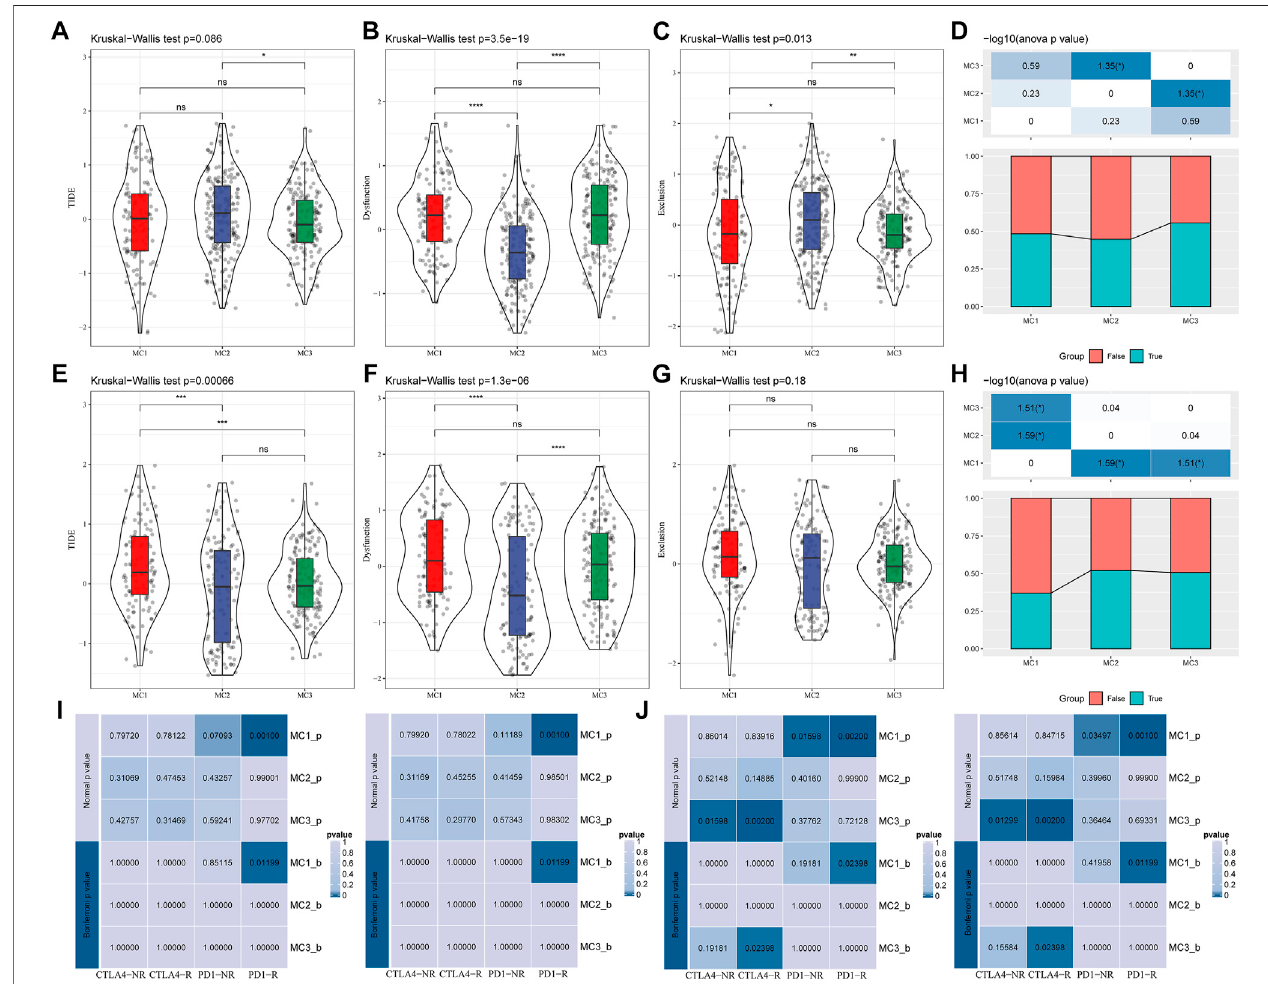
FIGURE 4 | The immunotherapy response difference between the three clusters. (A) TIDE scores of all three metabolic subtypes in the TCGA cohort. (B) T cell dysfunctionscoresofallthreemetabolicsubtypesintheTCGAcohort. (C) TcellrejectionscoresofdifferentmetabolicsubtypesofTCGA. (D) Immuneresponsestatusin differentmetabolicsubtypesofTCGA. (E) TIDEscoresofdifferentmetabolicsubtypesintheCGGAcohort. (F) Tcelldysfunctionscoresofdifferentmetabolicsubtypesin the CGGA cohort. (G) T cell rejection scores of different metabolic subtypes in the CGGA cohort. (H) Differences of immune response status in different metabolic subtypes in the CGGA cohort. (I) Different immunotherapy sensitivity in programmed cell death protein 1 inhibitor therapy in the TCGA cohort. (J) Different immunotherapy sensitivity in programmed cell death protein 1 inhibitor therapy in the CGGA cohort.